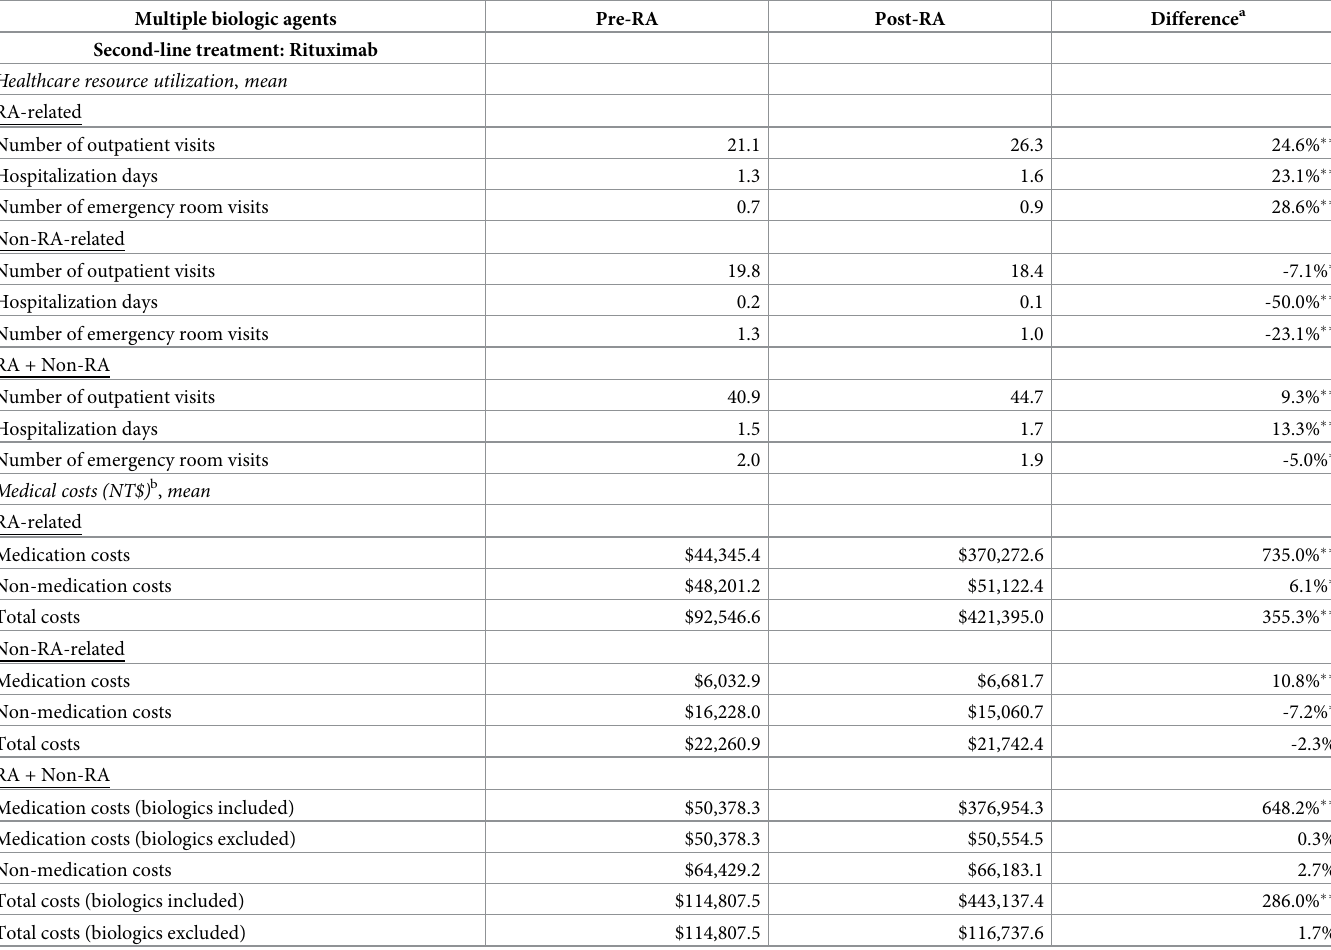
Table 5. Differences in healthcare resource utilization and direct medical costs of patients with rheumatoid arthritis (RA) before and after the use of second-line biologic